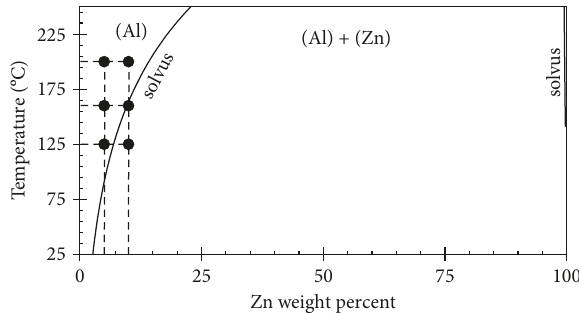
Figure 2: Partial Al-Zn phase diagram based on Chen and Chang’s work [14] indicating the matrix nominal compositions and testing